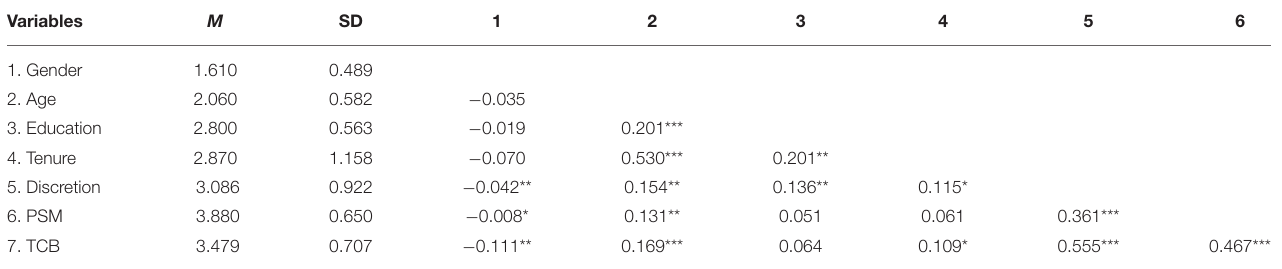
TABLE 4 | Descriptive statistics.